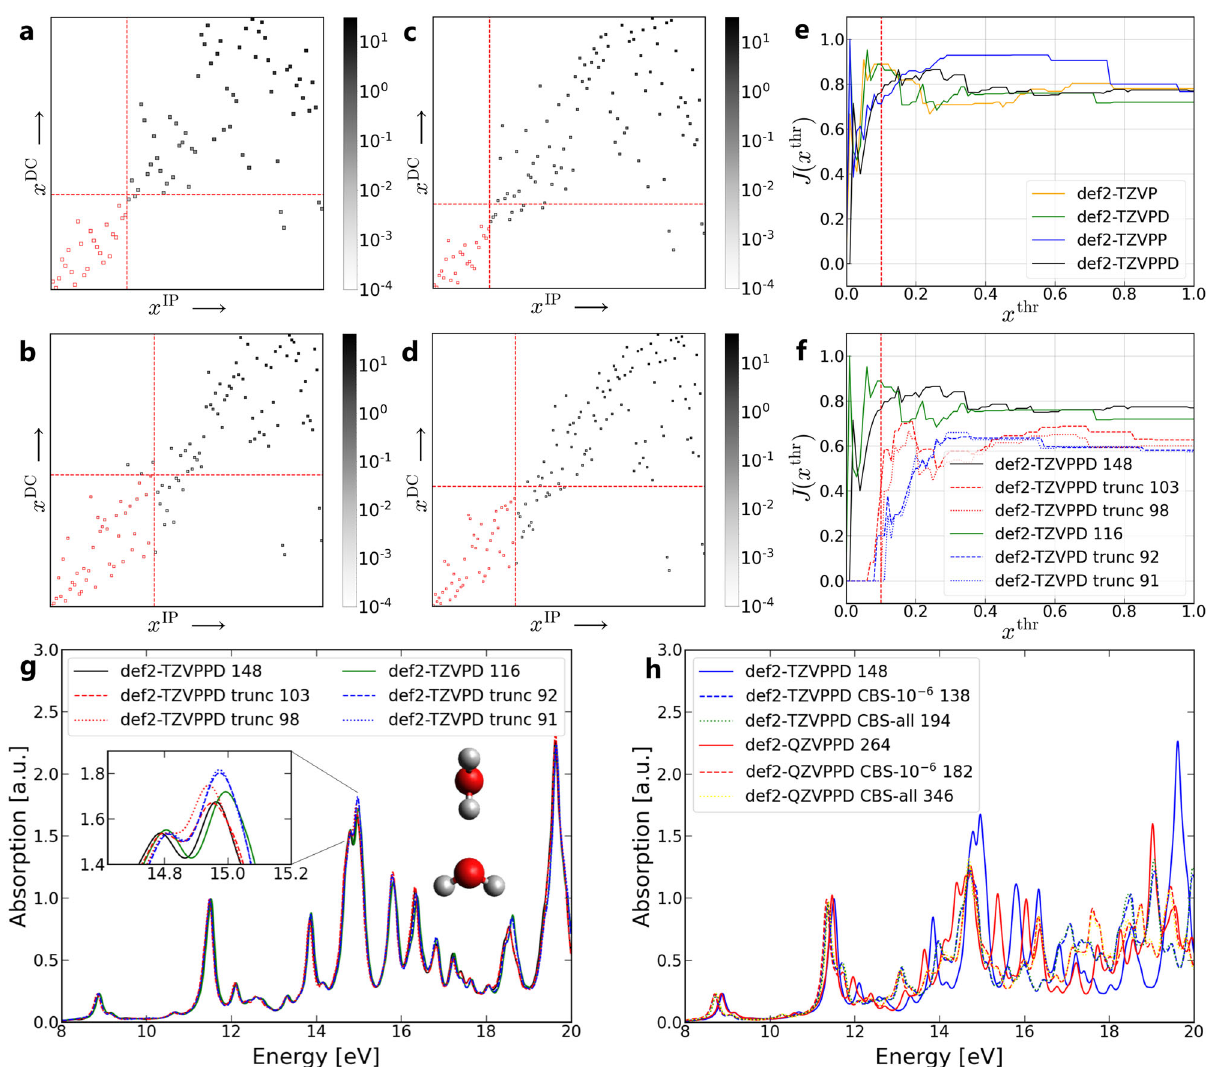
Fig. 3 | RT-TDHFcalculationsoftheH 2 Odimer. x DC - x IP mapobtained with a